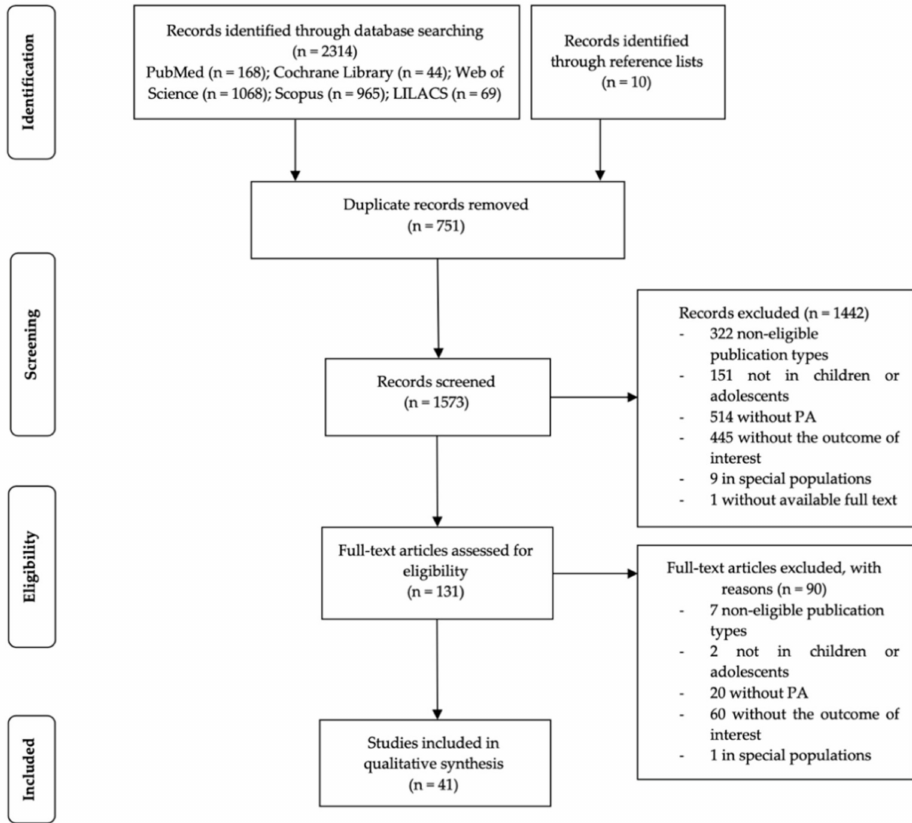
Figure 1. Flow diagram. LILACS, Latin American and Caribbean of Health Sciences Information System; PA, Physical